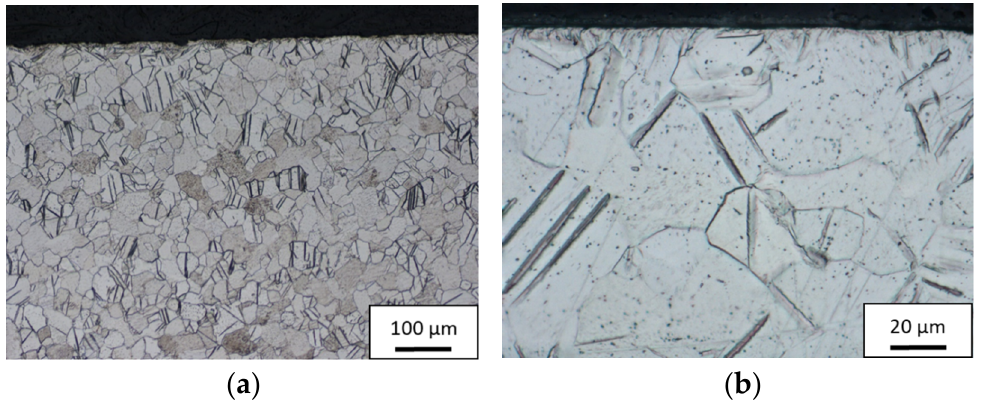
Figure 8. Microstructure of as-received titanium Grade 2: ( a ) longitudinal cross-section, ( b ) transverse cross-section—optical light microscopy.